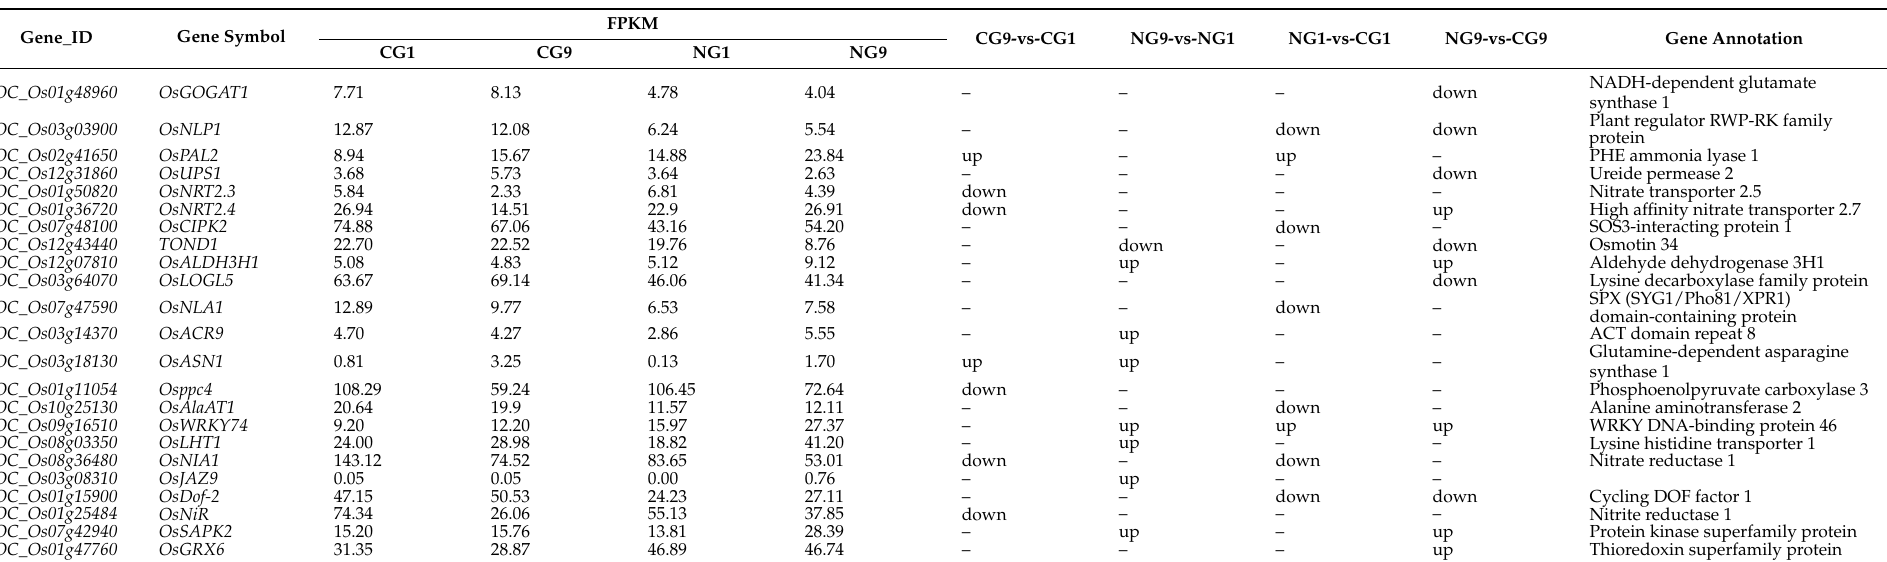
Table 2. The expression levels of 23 DEGs in G1 and G9 under LN and control conditions that are known to be functionally involved in nitrogen